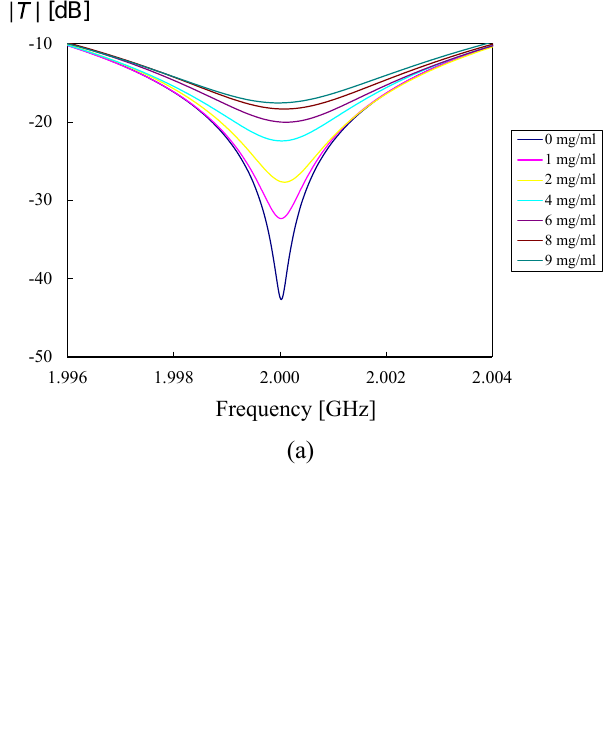
Figure 4: Experimental set-up based on interferometry. The interferometric method has been tested for different frequencies in the range 2-6 GHz. We present in figure 5, the measured transmission coefficient magnitude for the different NaCl concentrations at the test frequency of 2 and 5.9 GHz. In this condition, the interferometry procedure is performed for a reference liquid corresponding to de-ionized water at an ambient temperature of 25°C. The quality factor at -3 dB bandwidth is set around 10000 and 21500 at 2 and 5.9 GHz respectively. From this graphs, we can note that, when the NaCl concentration increases, the resonant frequency is shifted and the quality factor